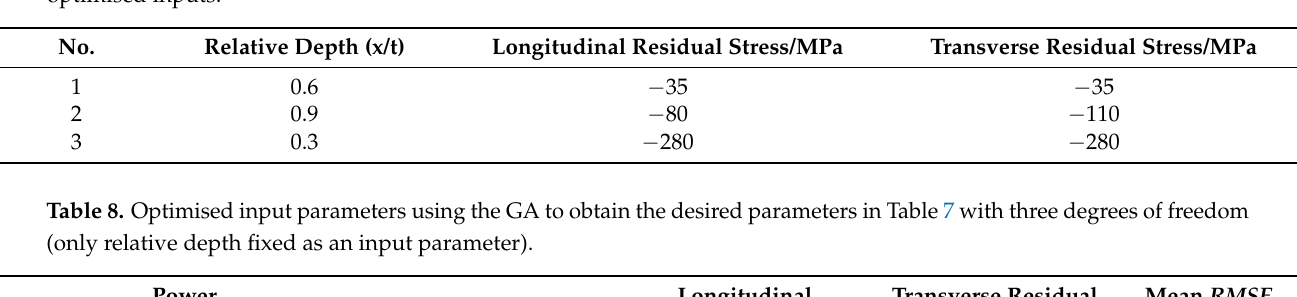
Table 7. Case study–1 using GA: Desired longitudinal and transverse residual stresses at different depths for obtaining optimised inputs.